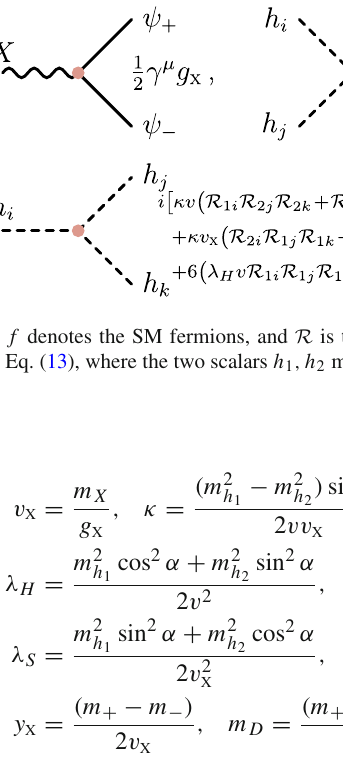
Fig. 2 Schematic diagram for the 2- and 3-component vector-fermion dark matter scenarios. We consider m + to have a fixed value and the gray region represent parameter space where the all three dark sector particles ( X μ ,ψ + ,ψ − ) are stable, whereas the white regions represent the 2-component scenarios where ψ + and X μ are unstable,